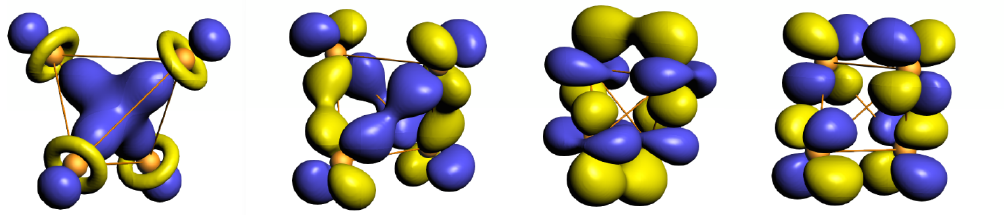
Figure 9. Examples from each class of d -derived tetrahedral FOs. From left to right, tetrahedral orbitals that are: a class I FO that is a mixture of σ and π bonding along each tetrahedral edge giving a FO bond order of 6; a class II FO that is σ bonding along four edges and weakly δ anti-bonding along two edges with a bond order of 2; a class III FO that is δ bonding along two edges and π anti-bonding along four edges with a bond order of -2; and a class IV FO that is δ anti-bonding along two edges and π anti-bonding along four edges with a bond order of